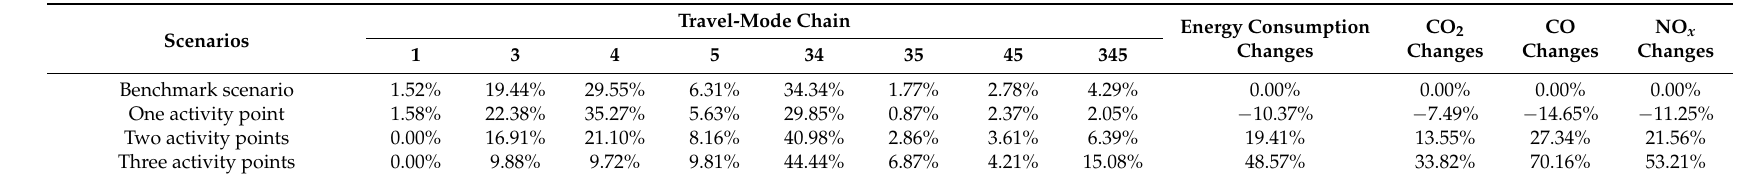
Table 13. Comparison of energy consumption and emissions under different holiday activity